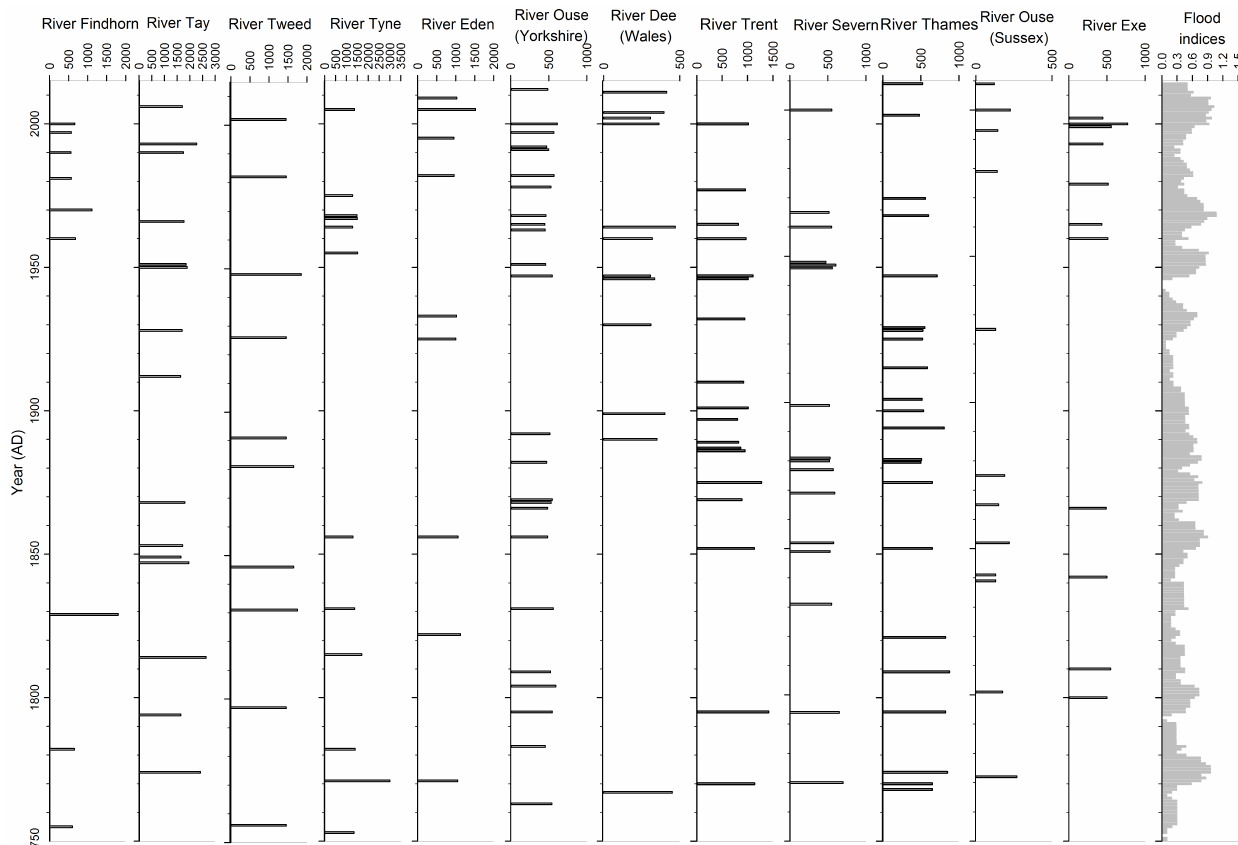
Figure 2. Historical flood chronologies for sites across Britain, showing events that exceed the 0.9 percentile (based on the instrumental record; river discharges are given as m 3 s − 1 ). River chronologies (left–right) Findhorn, Tay, Tweed, Tyne, Eden, Ouse (Yorkshire), Dee (Wales), Trent, Severn, Thames, Ouse (Sussex), Exe, and flood indices